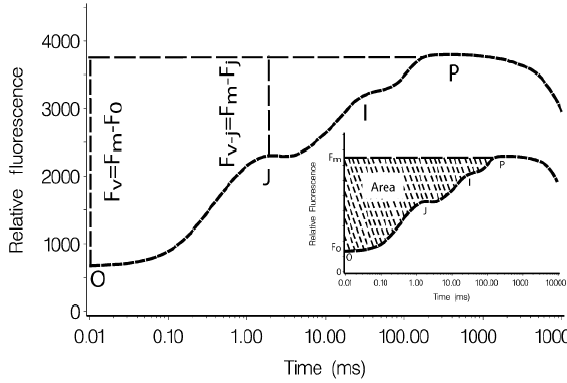
Fig. 1. Chlorophyll fluorescence curve (kautsky curve) recorded with Handy PEA instrument in a 30 min dark- adapted leaf (adopted by Abbaspoor and Streibig,